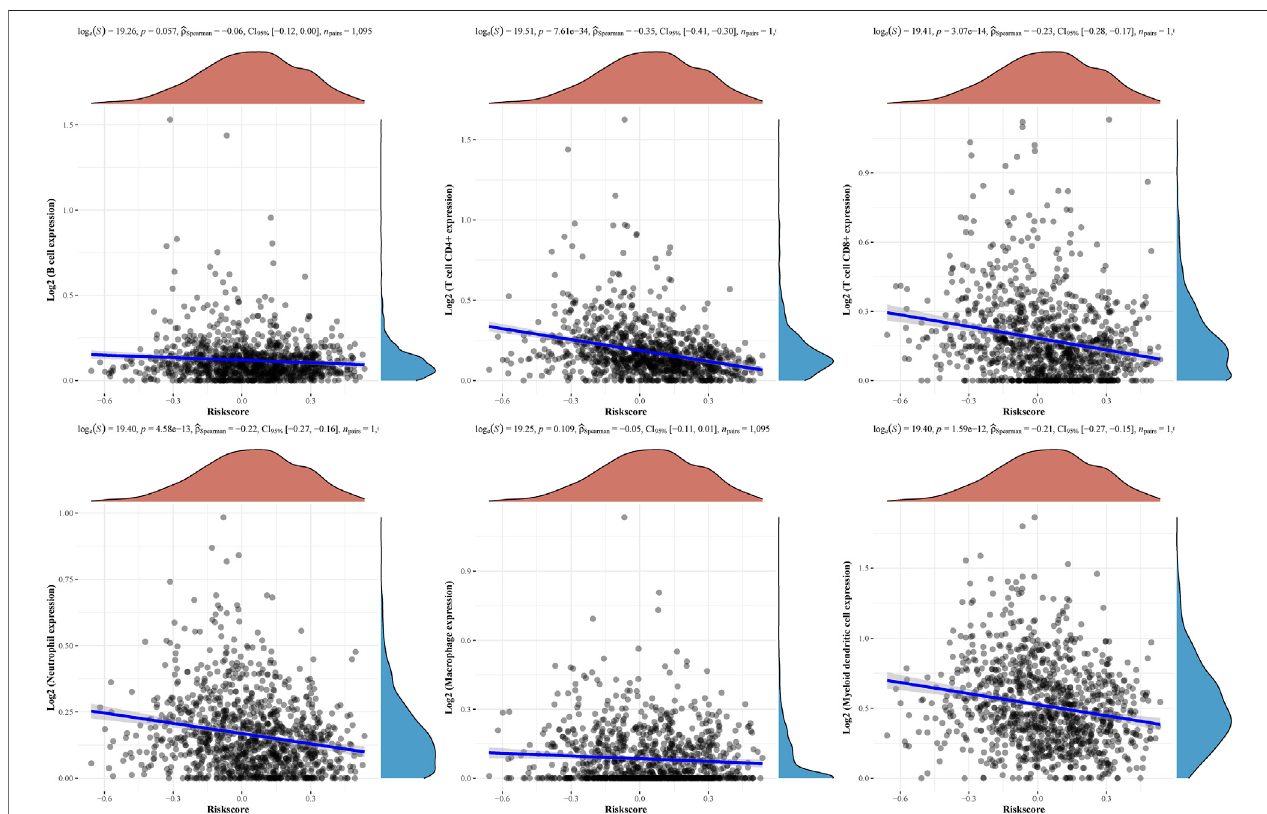
FIGURE 6 | The relationships between the risk score model and immune cell in fi ltration were investigated based on TCGA samples.